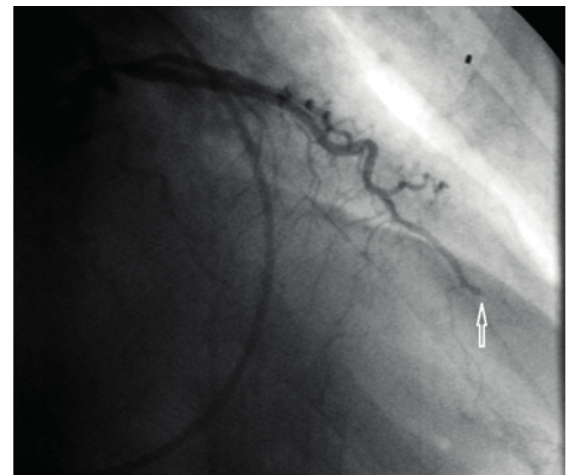
Figure 2. Coronarography showing occlusion in the distal part of left anterior descending artery.